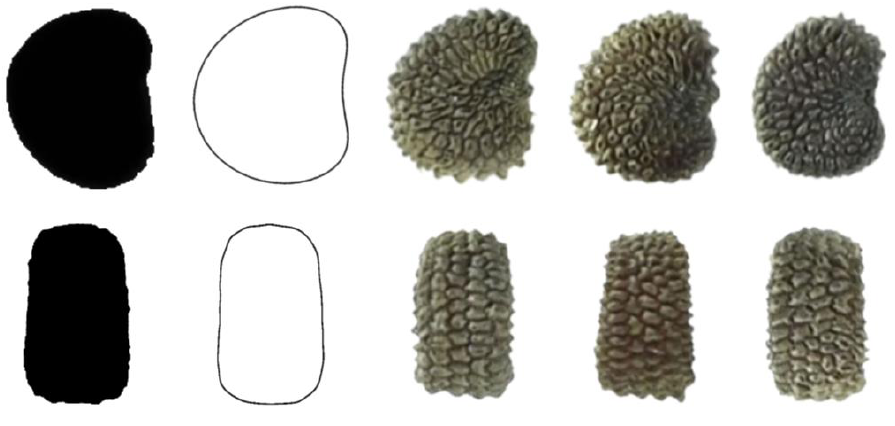
Figure 19. Silene multiflora : average silhouettes (left), the models giving best scores with 20 seeds (LM8 and DM10), and three representative images for the lateral (above) and dorsal (below) seed views. Bar represents 1 mm.